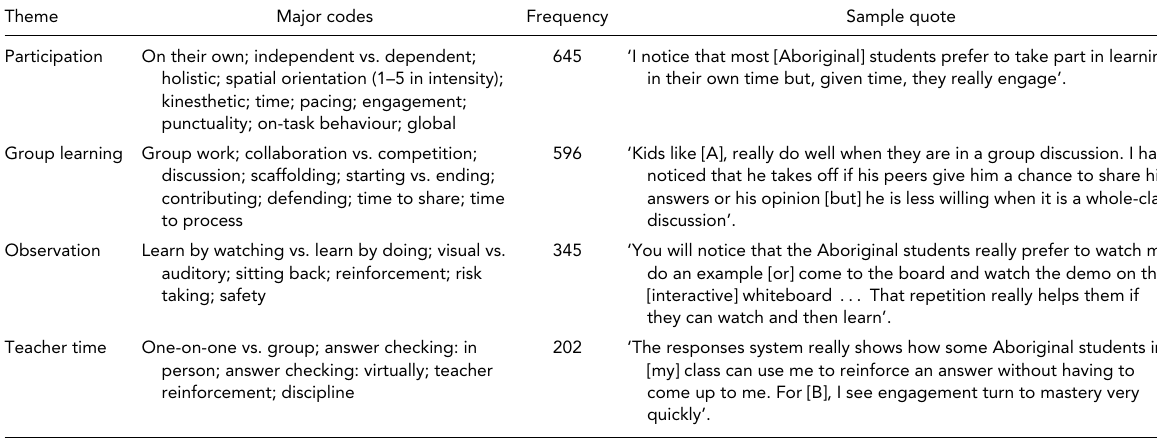
TABLE 3 Transcribed Interviews by Theme, Major Code, Frequency and Sample Quote Theme Major codes Frequency Sample